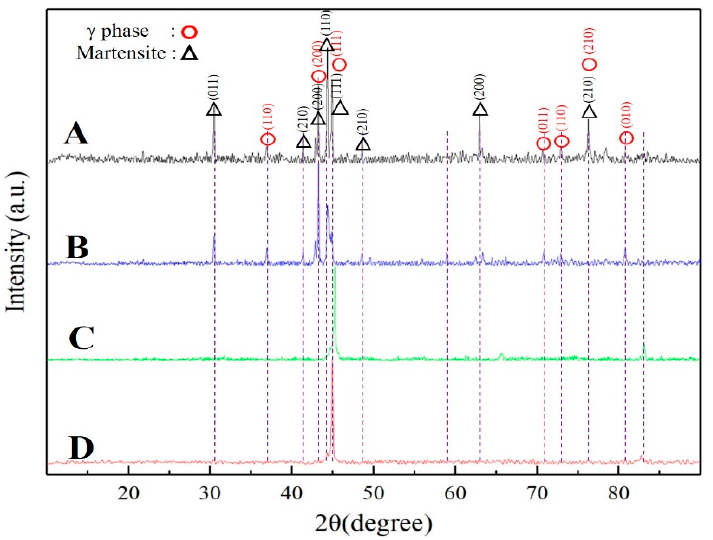
Figure 3. The XRD patterns of samples (A) Sample a; (B) Sample b; (C) Sample c; (D) Sample d.